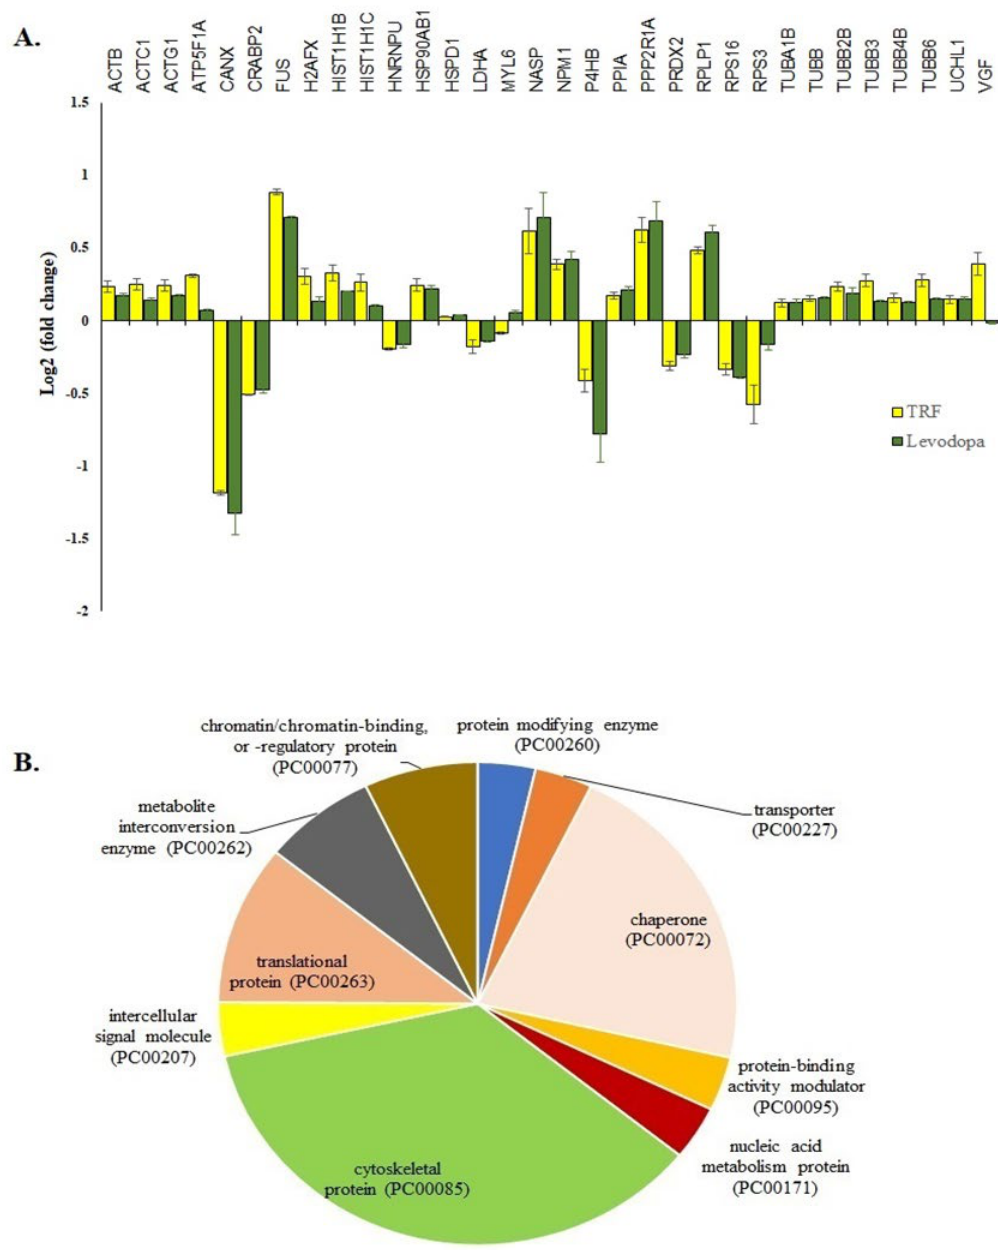
Figure 3. The 32 common proteins expressed in TRF and levodopa treated diff-neural cells. ( A ) Histogram shows the different fold change expressions of the 32 common proteins ( p < 0.05) regulated by treatment of levodopa or TRF on diff-neural cells. The horizontal coordinate (x-axis) represents the types of protein, and the vertical coordinate (Y-axis) denotes the difference in fold change (logarithmic transformation at the base of 2). ( B ) Pie chart shows the classification of 32 proteins into 10 functional categories using PANTHER online database.